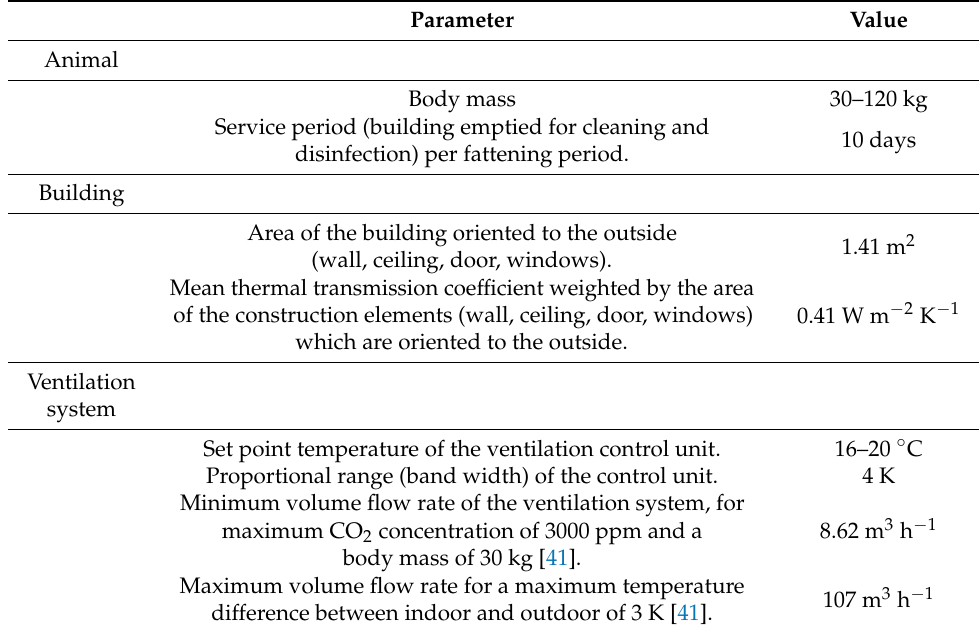
Table 1. System parameters for livestock, building, and ventilation system related to one animal place for the indoor climate simulation of a conventional livestock building